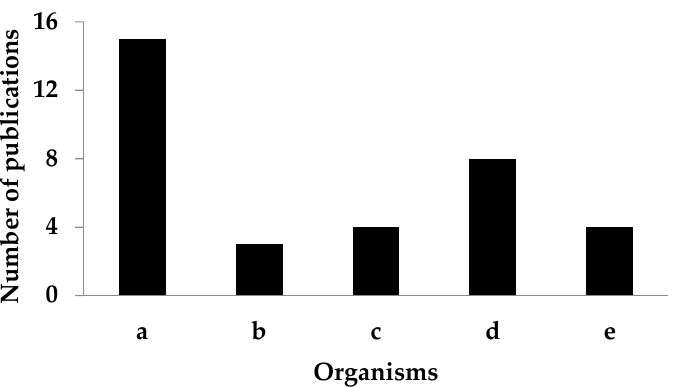
Figure 2. The number of publication related to safety and toxicity of phlorotannins in various organisms, including cell lines ( a ), microalgae, seaweed, and plants ( b ), invertebrates ( c ), animals ( d ), and humans ( e ).